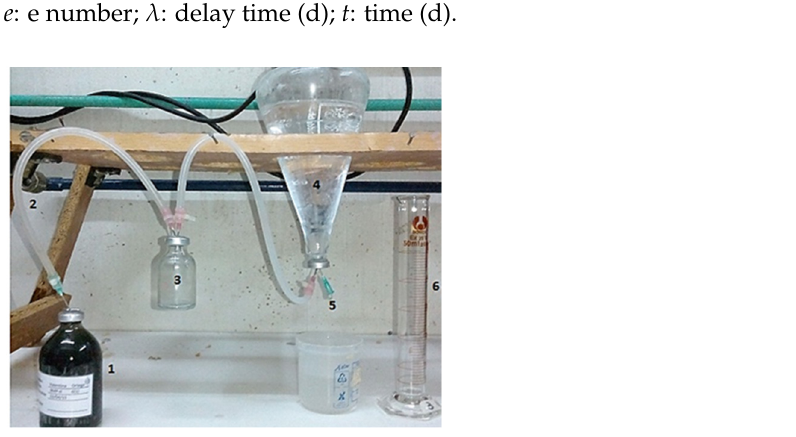
Figure 1. System used for the quantification of methane production by liquid displacement: (1) sample; (2) biogas outlet; (3) trap for liquid; (4) Mariotte bottle with alkaline solution; (5) volume output; (6) probe to measure displaced liquid.